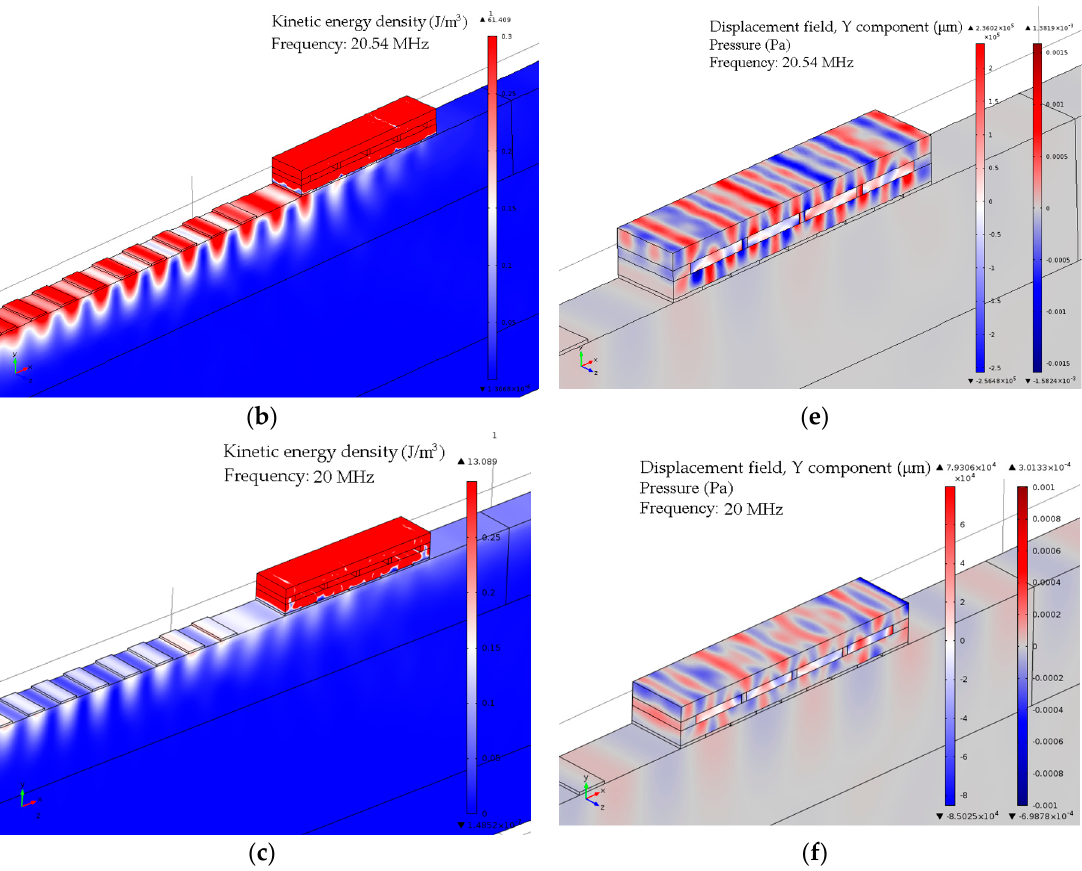
Figure 4. Kinetic energy density distribution at the SAW excitation frequency of ( a ) 20.45 MHz; ( b ) 20.54 MHz; ( c ) 20 MHz; displacement pattern and pressure distribution for the structure filled with liquid (speed of sound 1500 m/s) at the frequency of ( d ) 20.45 MHz; ( e ) 20.54 MHz; and ( f ) 20 MHz.